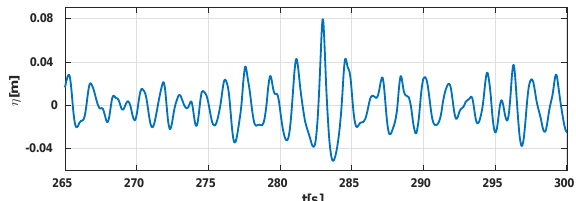
Figure 24. Case IW12. Zoomed version of the freak wave; the crest height is 1.31m and the wave height is 2.15 times the significant wave